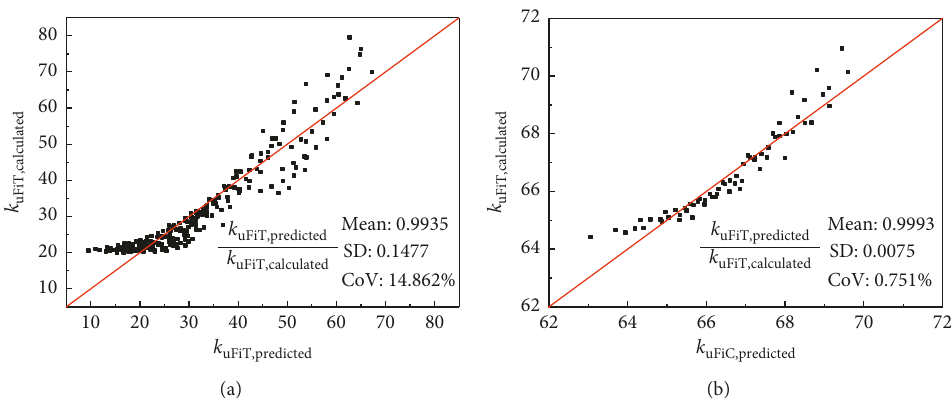
Figure 19: Calculated and predicted ultimate curvature coefficients. (a) Flange in tension. (b) Flange in compression. Table 3: Comparison between the measured displacement ductility and predicted displacement ductility. μ Δ (flange in tension) μ Δ (flange in Specimen